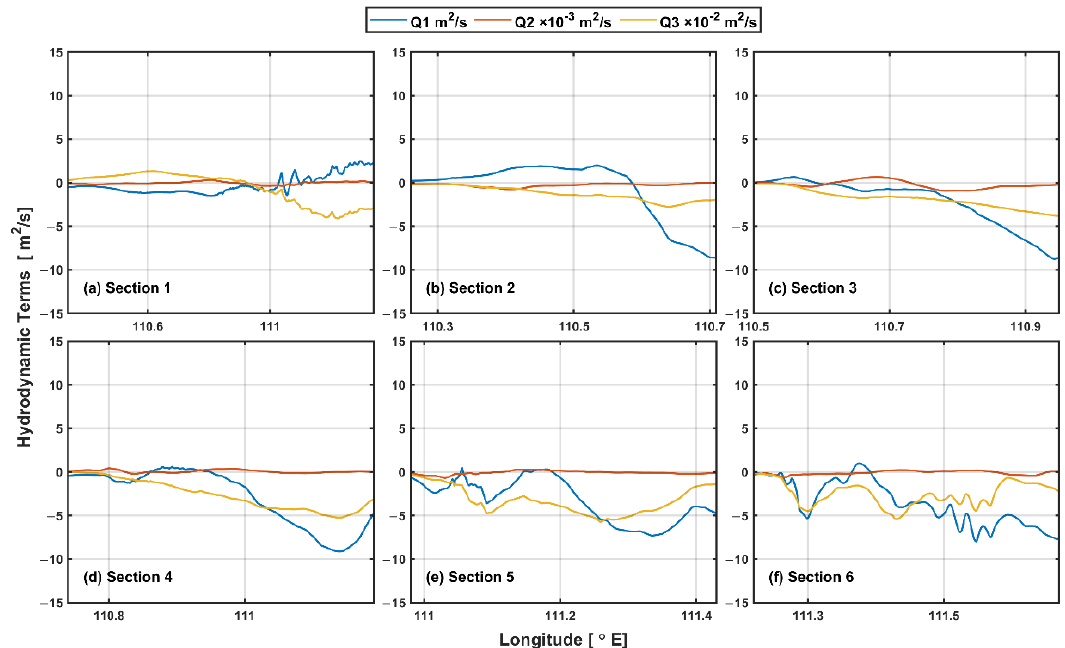
Figure 11. The contribution of different hydrodynamic terms to the salt flux in Sections 1 – 6 of Figure 1c. In Section 1, positive (negative) values indicate upslope (downslope) salt transport. In Sections 2 – 6, positive (negative) values imply northeastward (southwestward) salt transport.